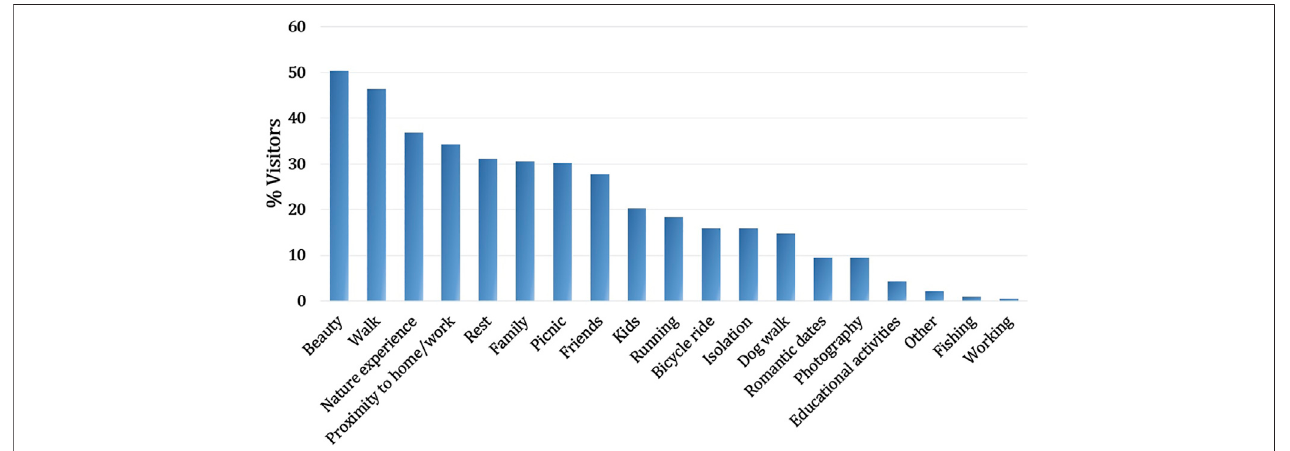
FIGURE 5 | Reasons for visiting the urban nature sites by percentage of visitors.